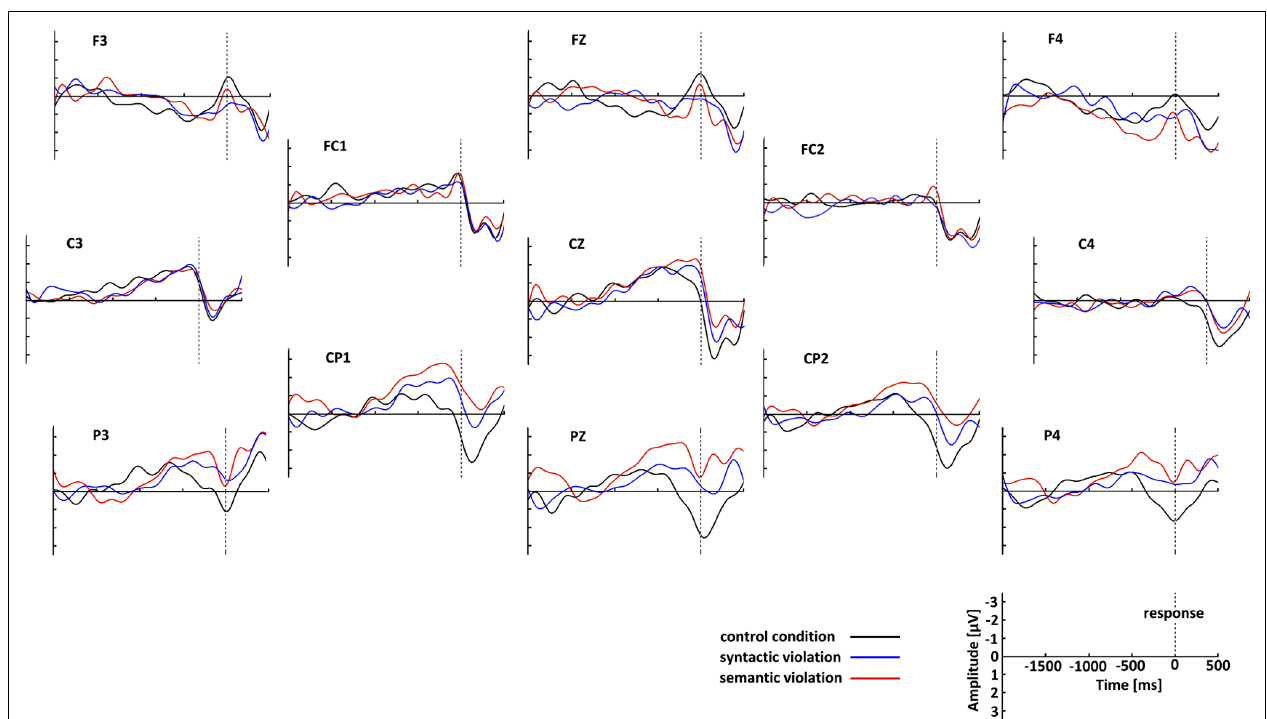
FIGURE 3 | Grand-average waveforms of the response-locked ERPs separately for the three conditions. The control condition is plotted in back, syntactic violations in blue, and semantic violations in red.The top of the figure corresponds to the anterior aspect of the head.The negative is plotted up.